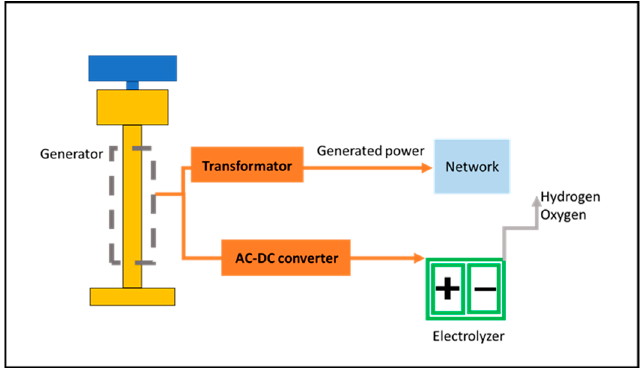
Figure 1. The process of power and hydrogen production with Searaser.